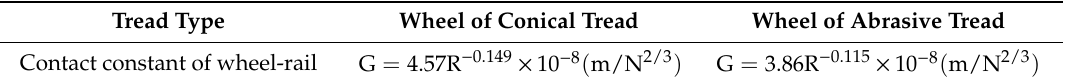
Table 2. Contact constant value of the wheel-rail.